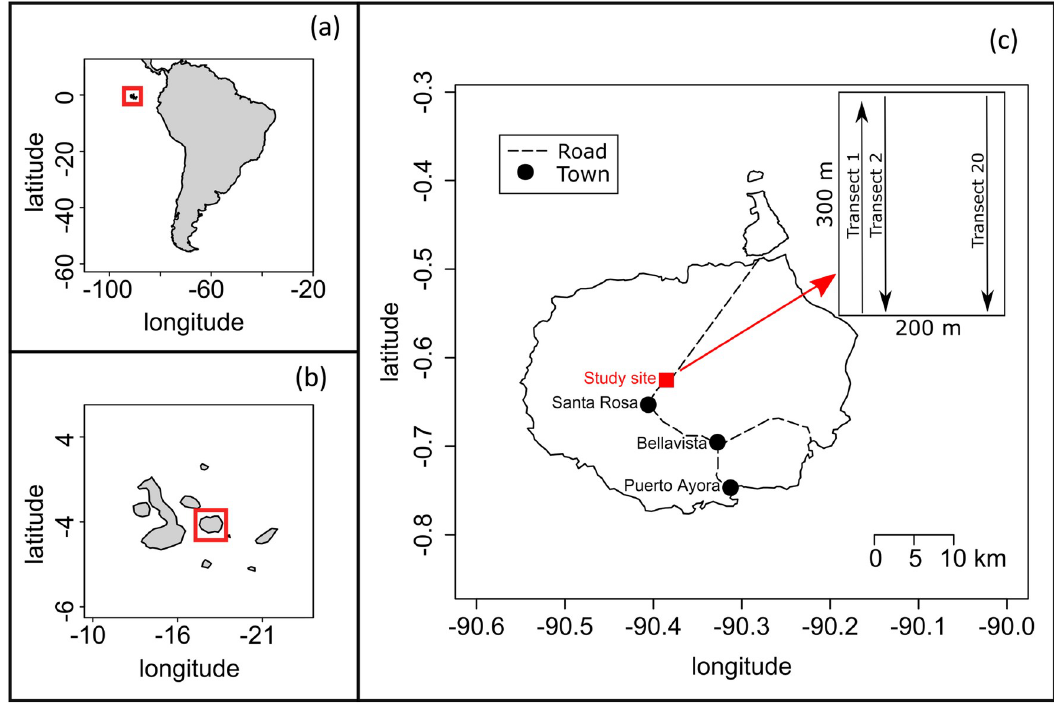
Fig 1. Location of the study site. (a) South America and the Galapagos Islands (red square). (b) Galapagos Islands with Santa Cruz (red square). (c) Santa Cruz with study site indicated in red and sketch of the sampling design. Projection: WGS 84 EPSG 4326.